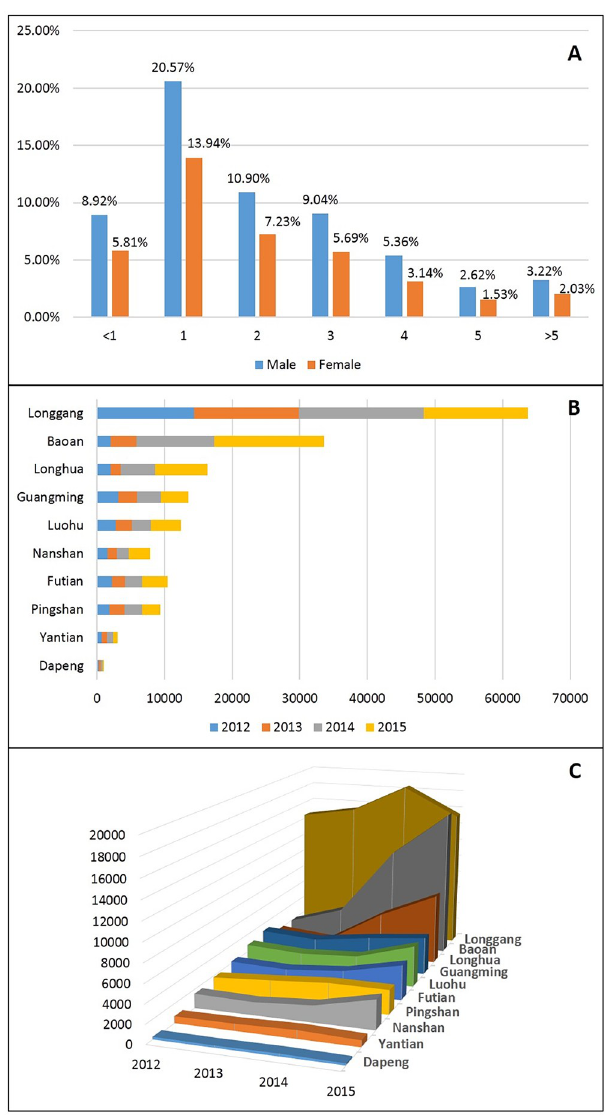
Fig 2. The statistical graph of the reported HFMD cases in Shenzhen, from 2012 to 2015. The characteristics distribution of age groups and sex, from 2012 to 2015(Fig.2.A). The distribution of the number of cases of each district from 2012 to 2015(Fig.2.B). The trends in the number of cases of each district from 2012 to